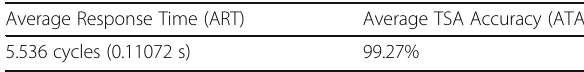
Table 2 Selected pareto point Average Response Time (ART)